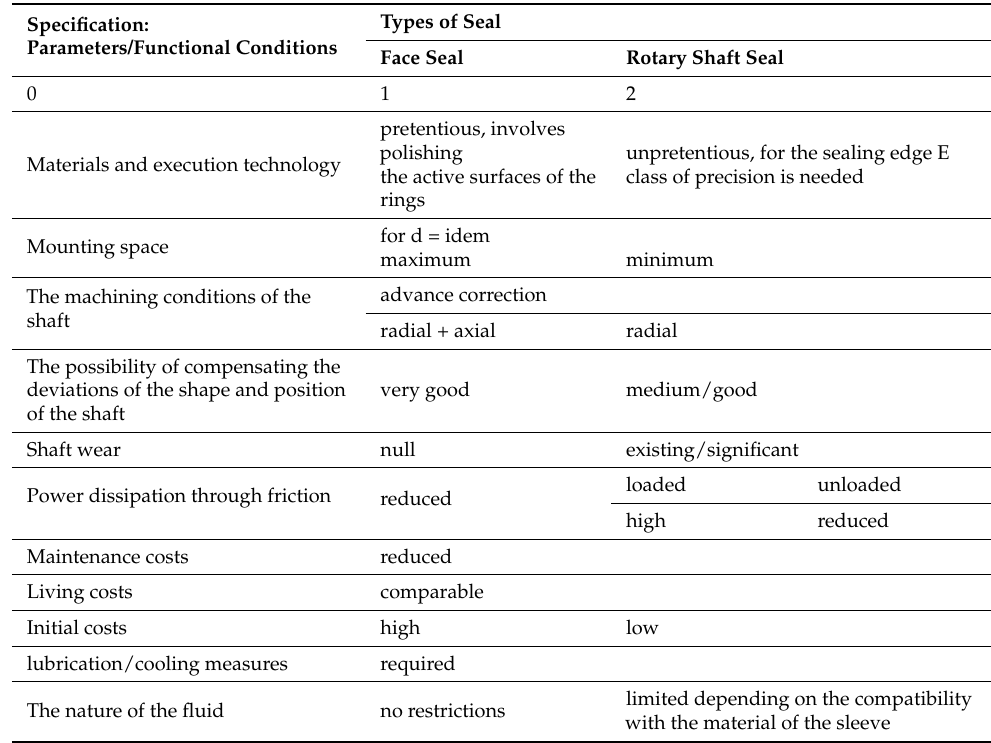
Table 2. Specification: parameters and functional conditions comparison between face seals and rotary shaft seals